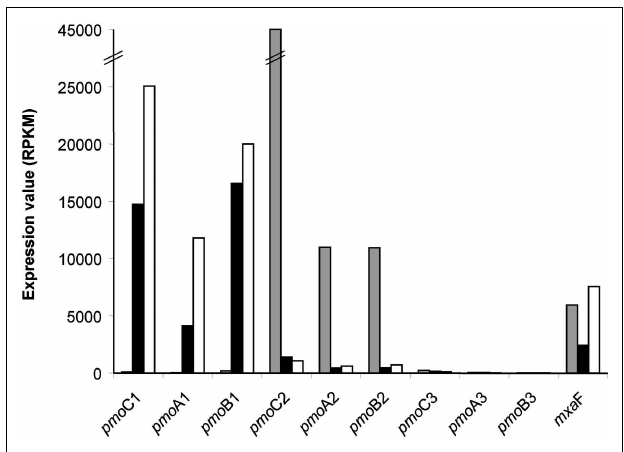
FIGURE 1 | Expression of the three pmo CAB operons, encoding the three subunits of the particulate methane monooxygenase (pMMO). Values from batch culture cells growing at µ max ( ), N 2 fixing cells ( (cid:4) ), and O 2 limited cells ( (cid:3) ) are expressed as RPKM (Mortazavi et al., 2008). Expression of mxaF ( xoxF ) encoding methanol dehydrogenase is shown for